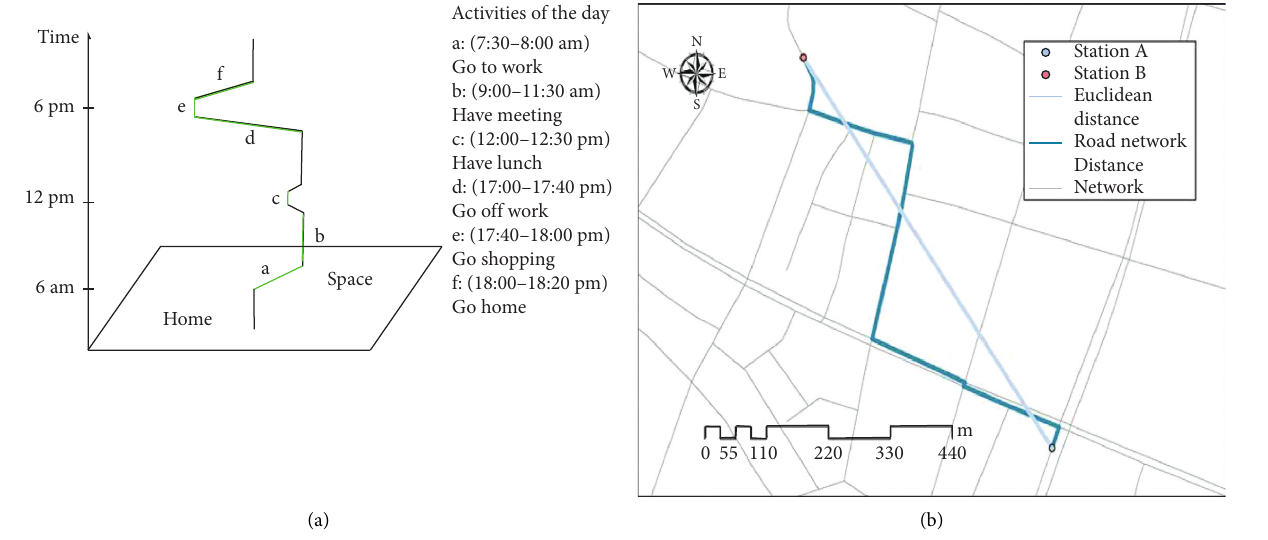
Figure 6: Space time path map. (a) Time space path diagram. (b) Spatial path map.